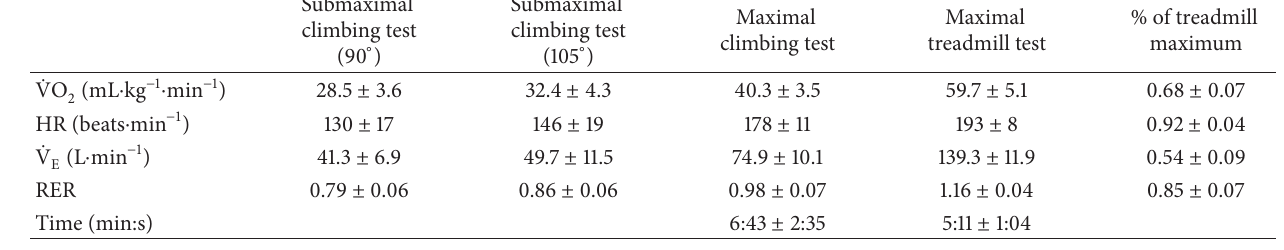
Table 1: Mean ( ± SD) oxygen uptake ( test.